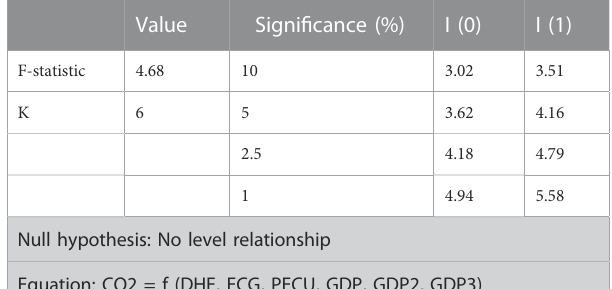
TABLE 3 Results of the bound